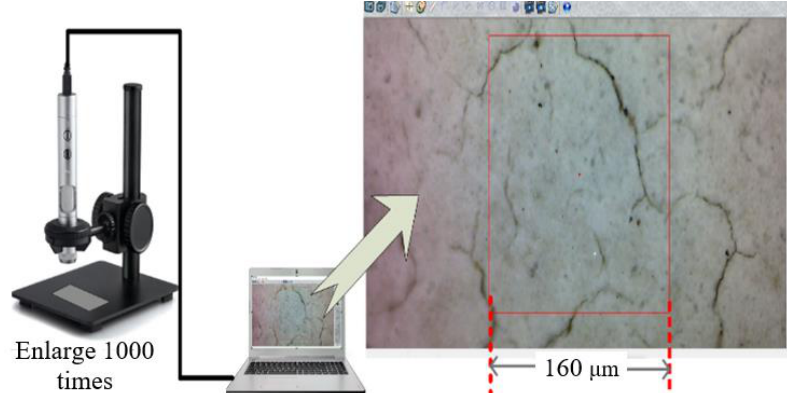
Figure 6. Characterization of the aging surface seen through the portable digital microscope-B011 [30].